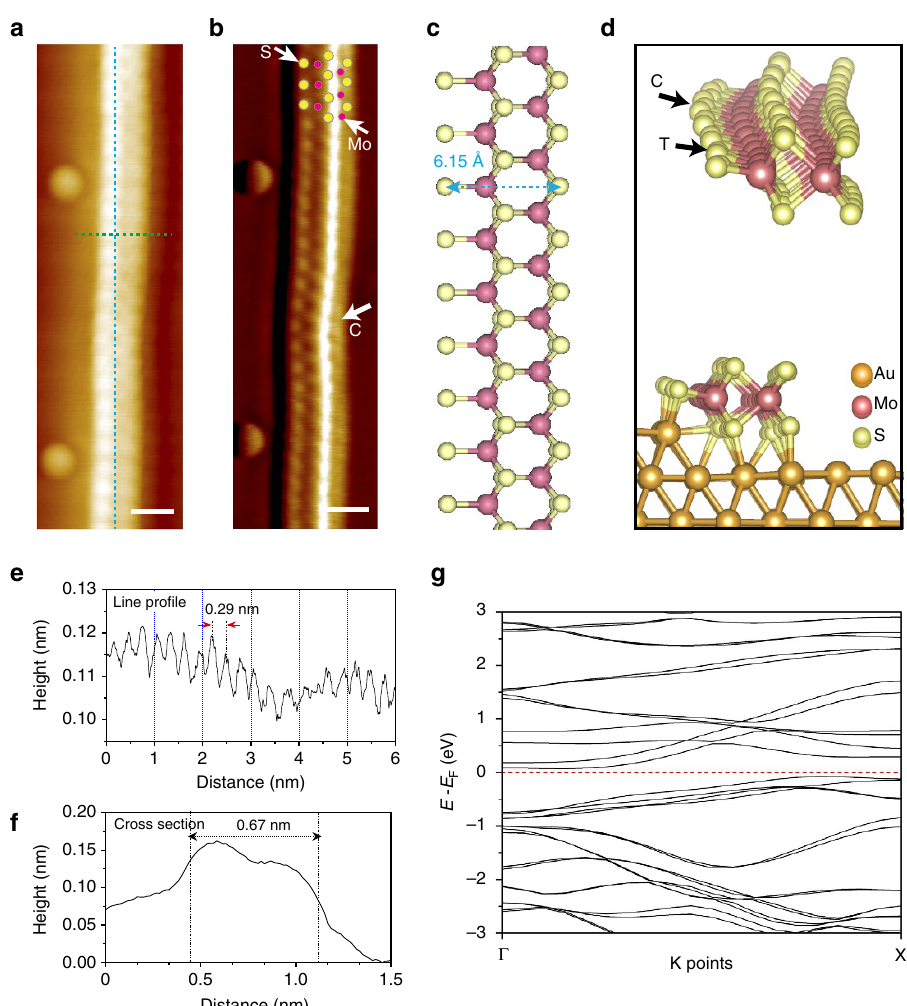
Figure 2 | Atomic structure of a single MoS 2 nanowire grown on the Au (755) surface. ( a ) High-resolution NC-AFM image of a single MoS 2 nanowire reveals the lateral topographic modulation with a period of 4.4nm ( f 0 ¼ 23.1kHz, df ¼ (cid:3) 16Hz, T ¼ 4.5K). ( b ) The corresponding derivative image of a resolves three atomic chains for a single MoS 2 nanowire. Mo(S) atom positions are indicated by rose (yellow) circles. In a laterally corrugated nanowire, the region closest to (furthest away from) the step edge is defined as crest, C (trough, T) site as marked by white arrows. ( c ) Schematic illustration of the atomic structure of a single MoS 2 nanowire (yellow ball: S, rose ball: Mo). ( d ) DFTsimulation of a single MoS 2 nanowire grown along the step edge of Au (755) surface (gold ball: Au atom). ( e ) The line profile obtained along the axis of a single MoS 2 wire reveals a compressed lattice spacing of 0.296nm. ( f ) The line profile across the MoS 2 nanowire. ( g ) Calculated band structure of a single suspended MoS 2 nanowire. Scale bars, 0.5nm in all NC-AFM